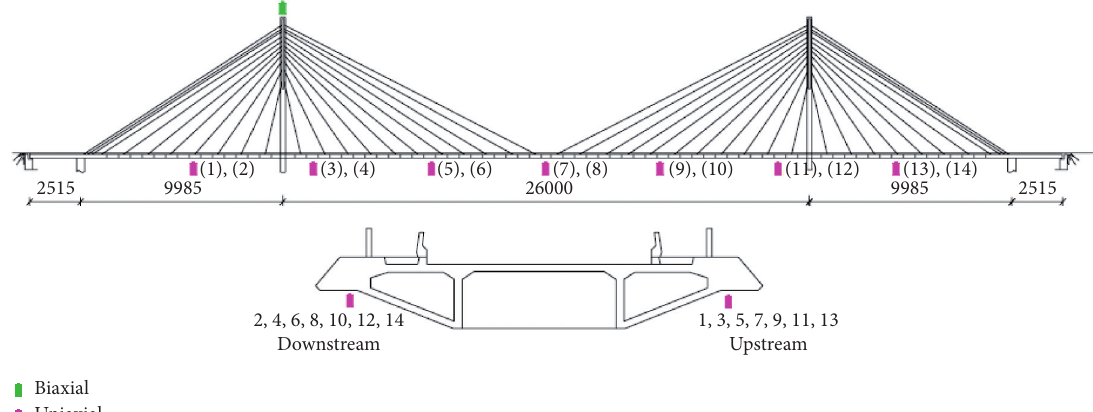
Figure 10: Placement of the accelerometers installed on Tianjin Yonghe Bridge as part of the SHM system [43].